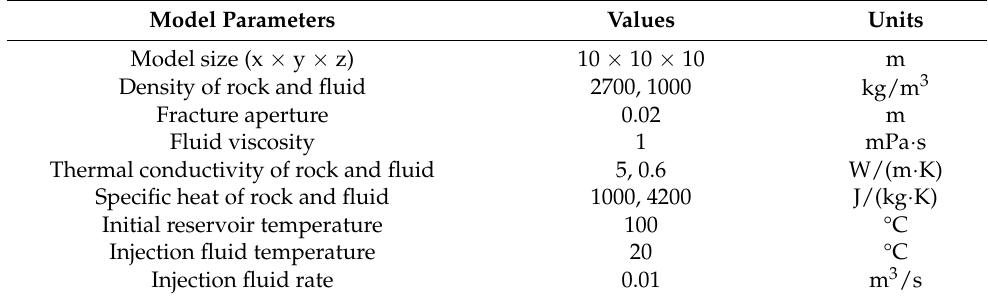
Table 2. Main computational parameters of the